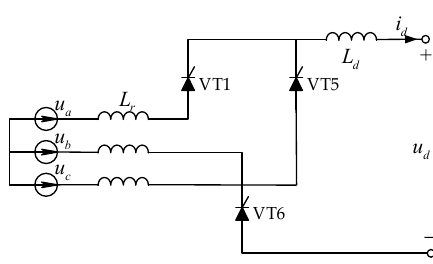
Figure 3. Equivalent circuit when VT1 is in conduction commutation state.